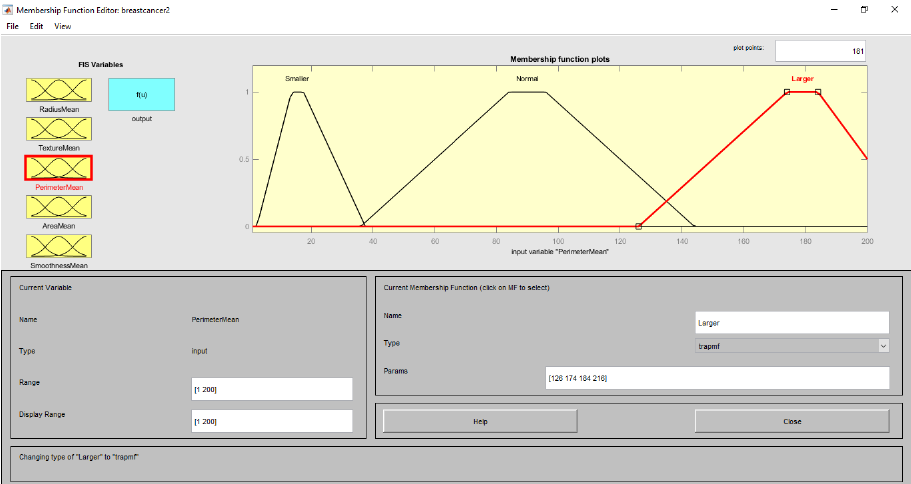
Figure 16. Membership functions of the linguistic variables of perimeter mean input.